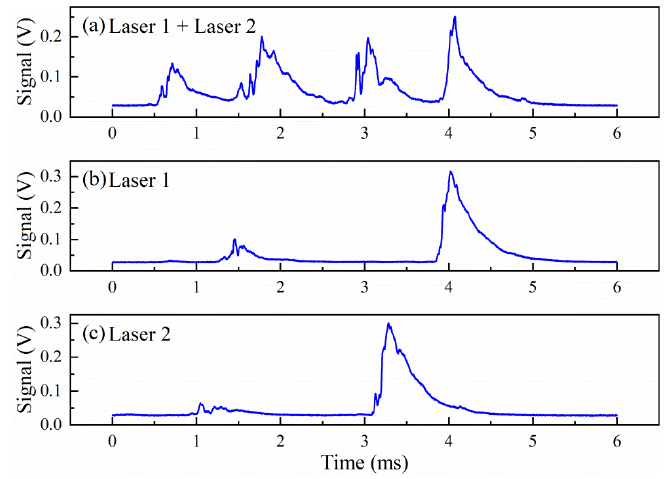
Figure 5. ( a ) Ringdown signals when both lasers are in resonance with the cavity within a short period of time, causing interference. ( b ) and ( c ): Ringdown signal when only one laser is dithered around cavity resonance while the other laser is set off resonance with the cavity. The signal fluctuation is caused by frequency fluctuation of the DFB diode lasers.